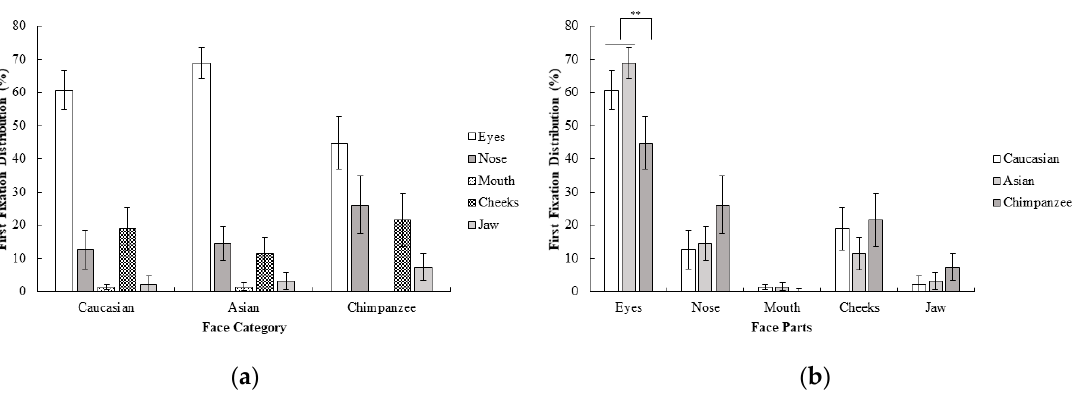
Figure 1. Mean percentage (with 95% CI) of first fixation frequency as a function of ( a ) face category and ( b ) face part in Experiment 1.